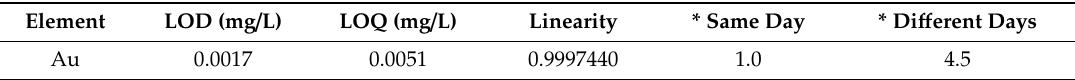
Table 2. Validation